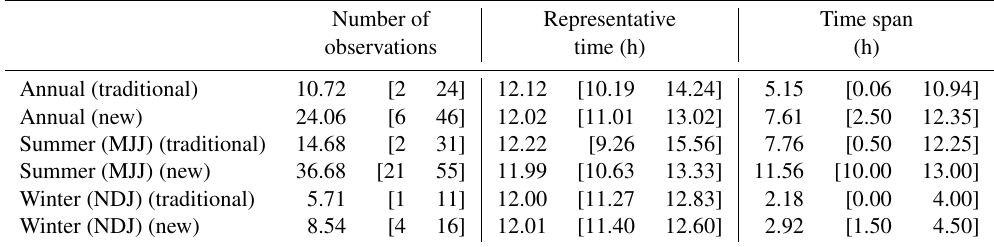
Table 1. Summary statistics for data shown in Fig. 2: number of contributing observations, representative observation time, and time span of contributing observations. For each case, values shown are the arithmetic means, and in brackets the lower 10th percentile and upper 10th percentile values are